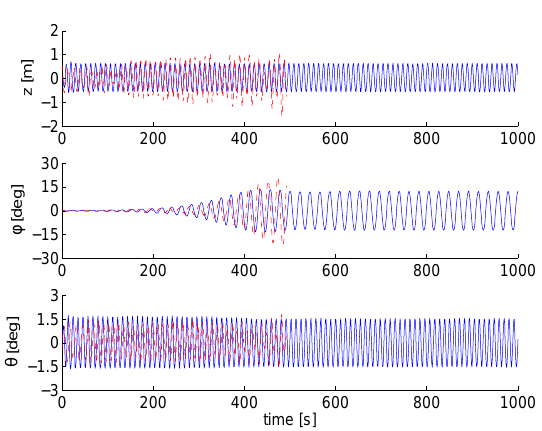
Figure 24: Max. roll angle vs ω e /ω 0 for A w = 2 . 5 m, ω = 0 . 4640 rad/s. Exp. dashed red, sim. solid